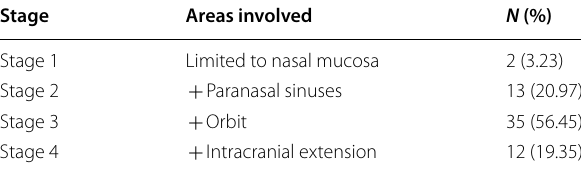
Table 4 Staging according to the extent of regional involvement